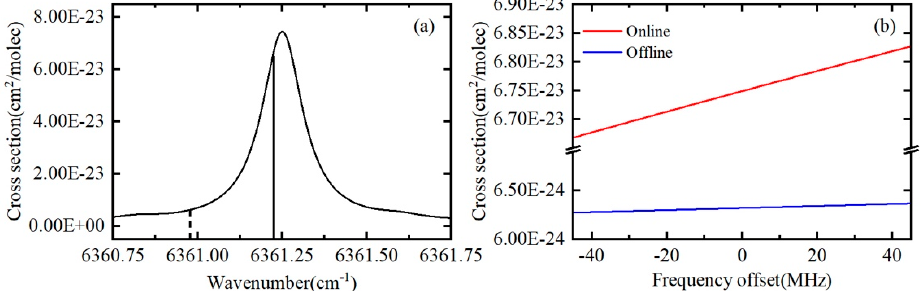
Figure 8. The absorption cross section of CO 2 at T = 296 K and p = 1013.25 hPa.